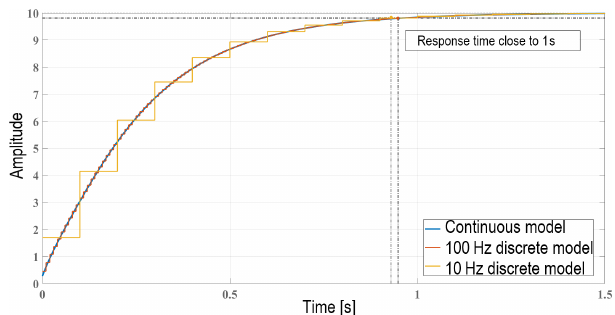
Figure 4. Step response of the continuous and discrete models of the bead